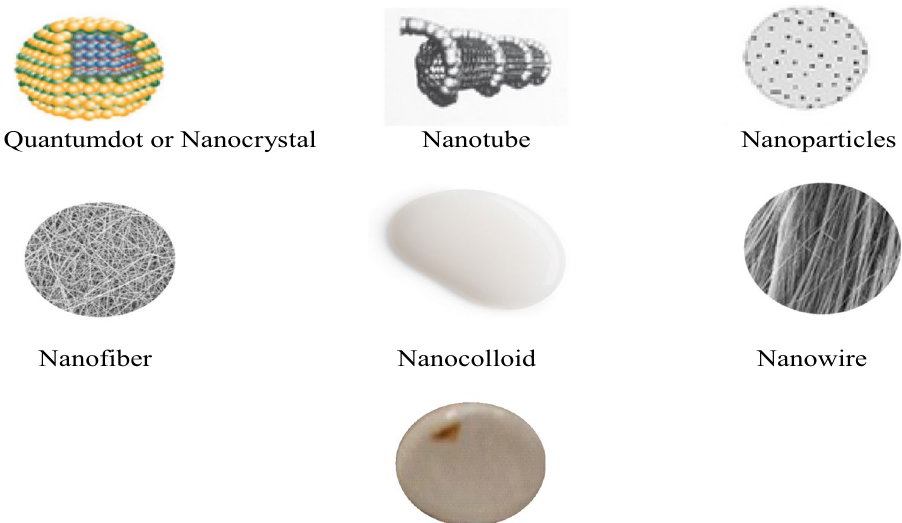
Fig. 1 Images of some nano-